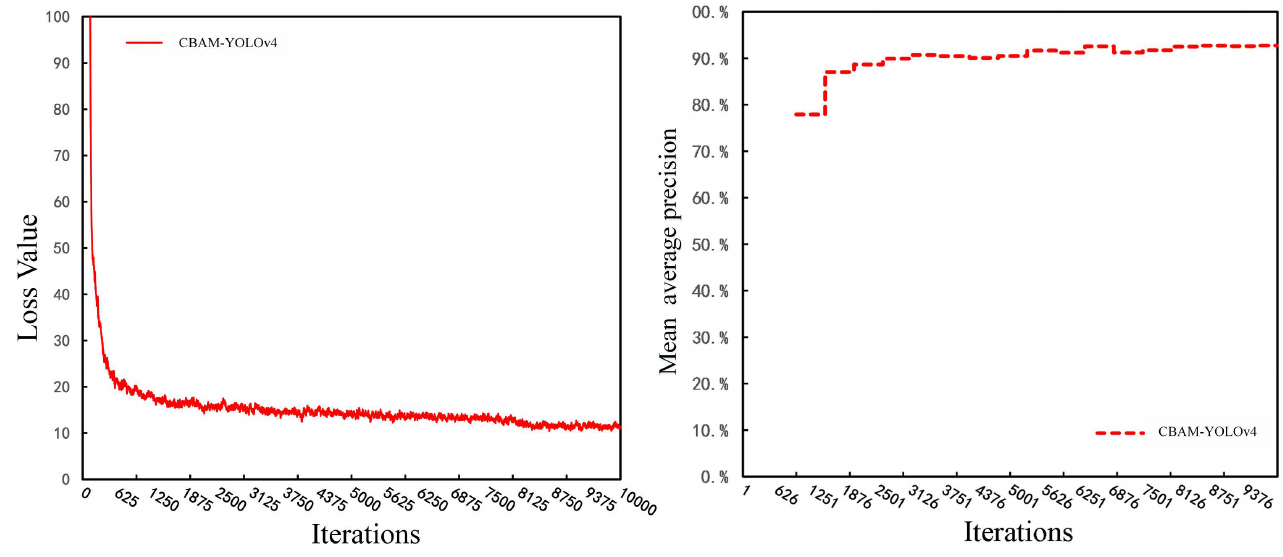
Figure 6. Loss value and mean average precision changes with